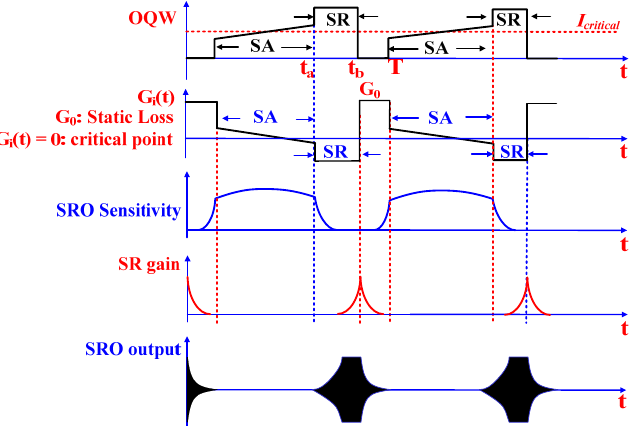
Figure 5. The timing diagram of the conventional SRO architecture with OQW.